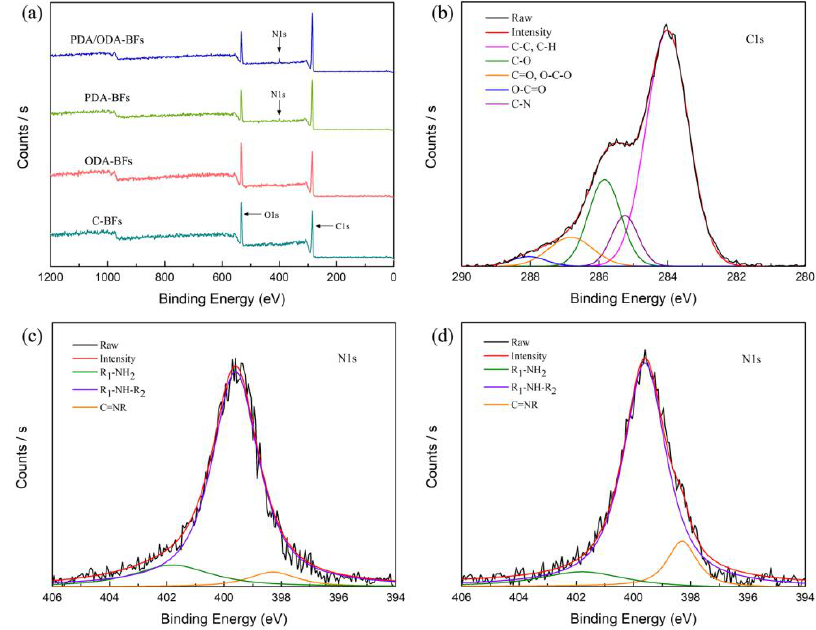
Figure 3. XPS wide-scan and high resolution spectra of BFs samples: ( a ) wide-scan XPS spectra of C–BFs, PDA–BFs, ODA–BFs and PDA/ODA–BFs; ( b ) C 1s core-level of PDA–BFs; ( c ) N 1s core-level of PDA–BFs; and ( d ) N 1s core-level of PDA/ODA–BFs.